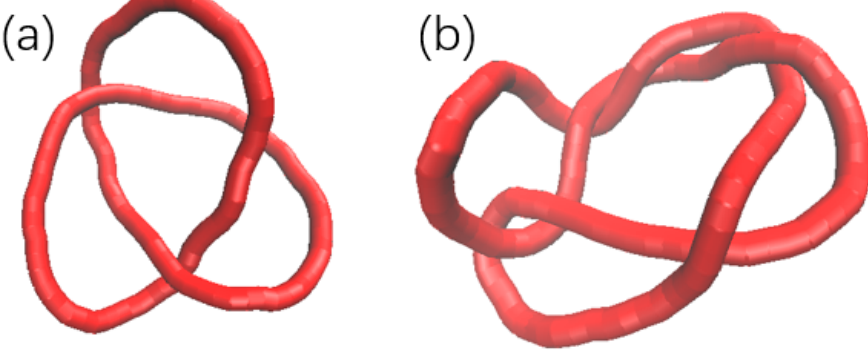
Figure 1. Typical snapshots for two topological knots ( a ) 3 1 -knot and ( b ) 6 1 -knot.